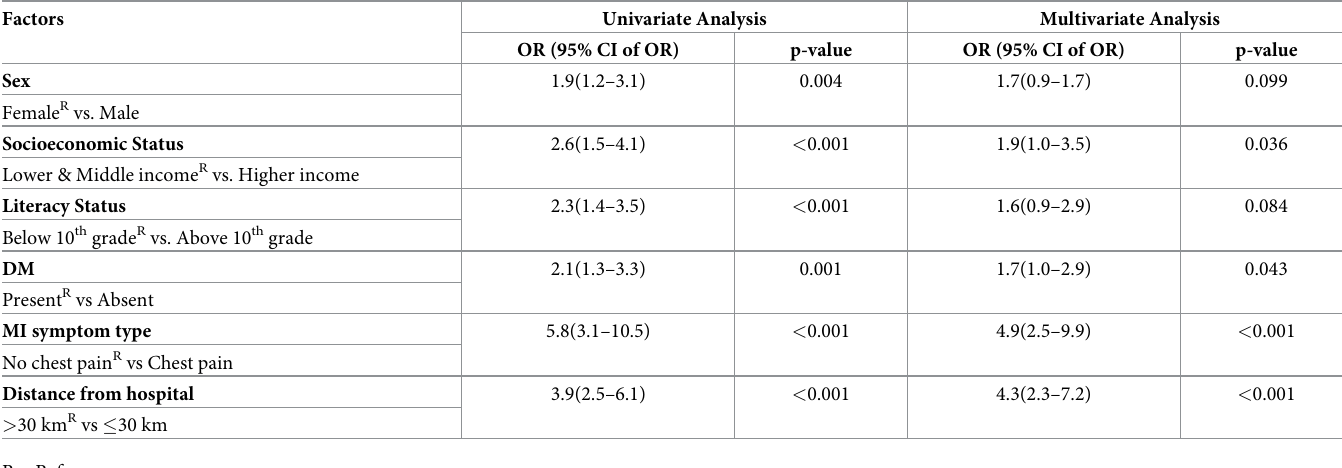
Table 5. Factors associated with pre-hospital delay in multivariate logistic